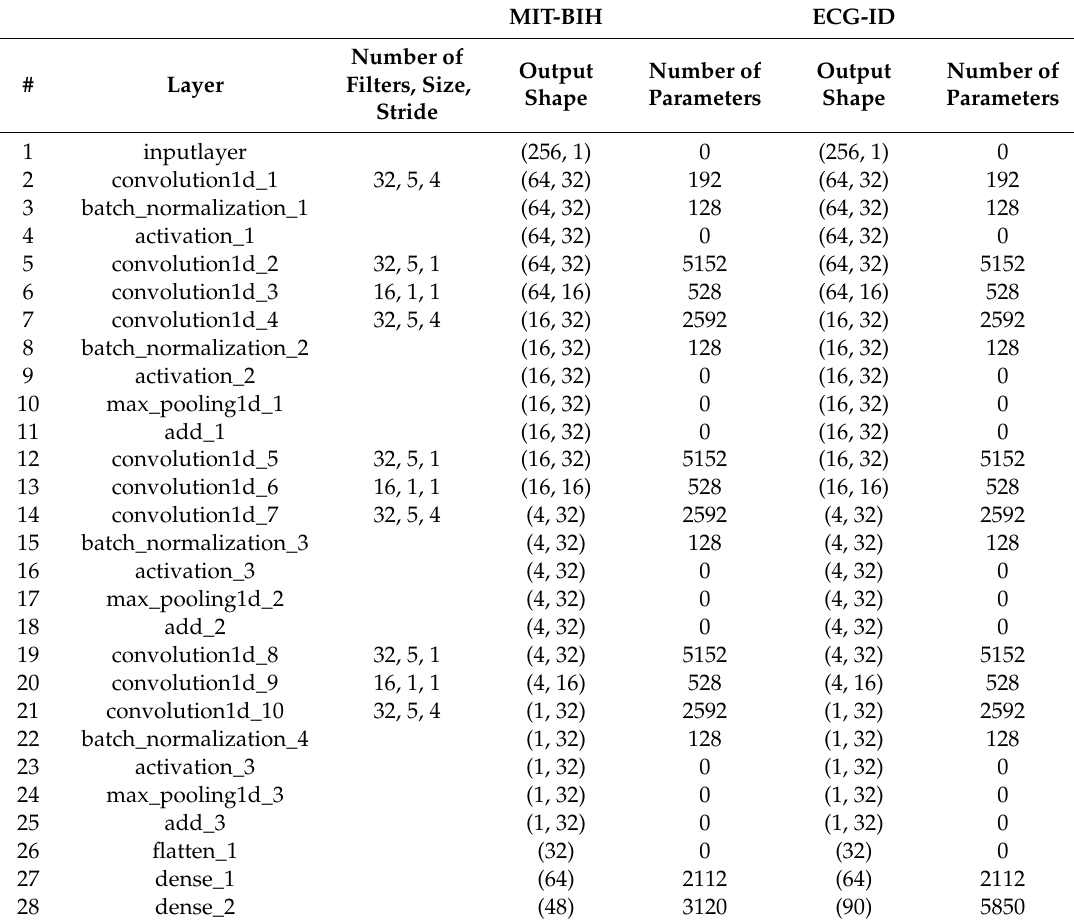
Table 2. Summary of the proposed RDSCNN algorithm.